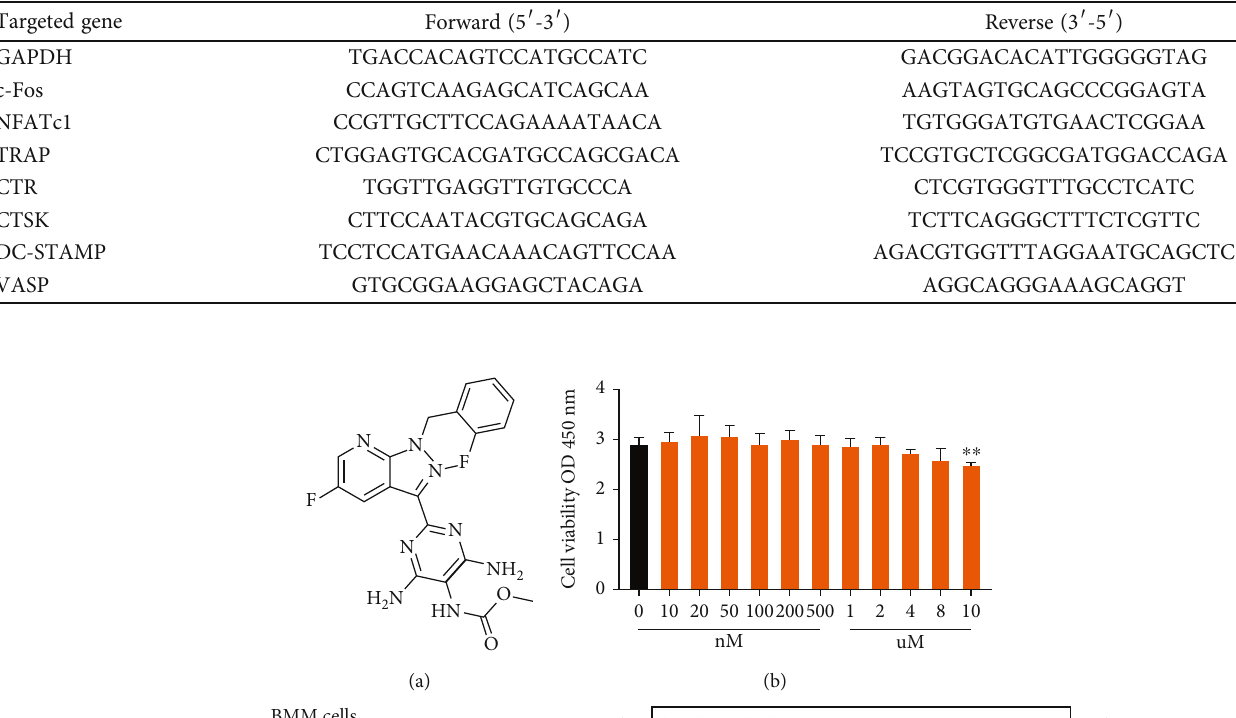
Table 1: Primers used for quantitative PCR.